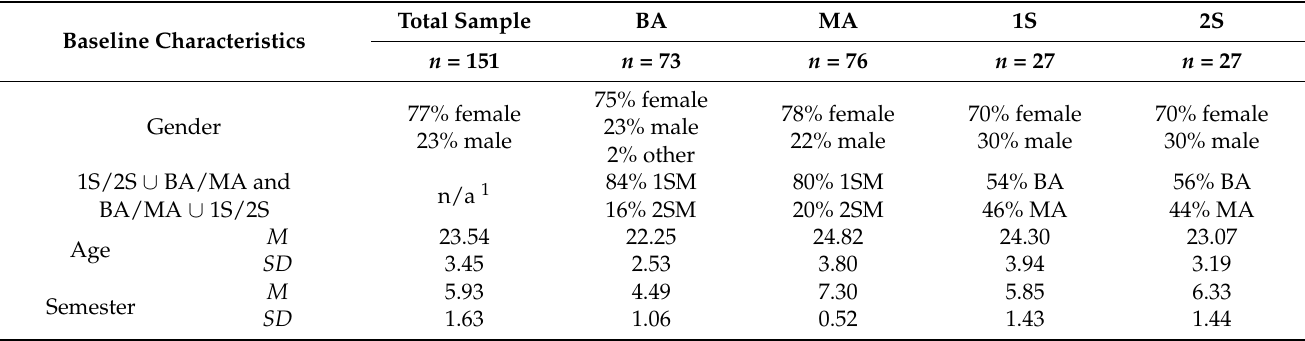
Table 3. Results of preliminary analyses regarding potential baseline